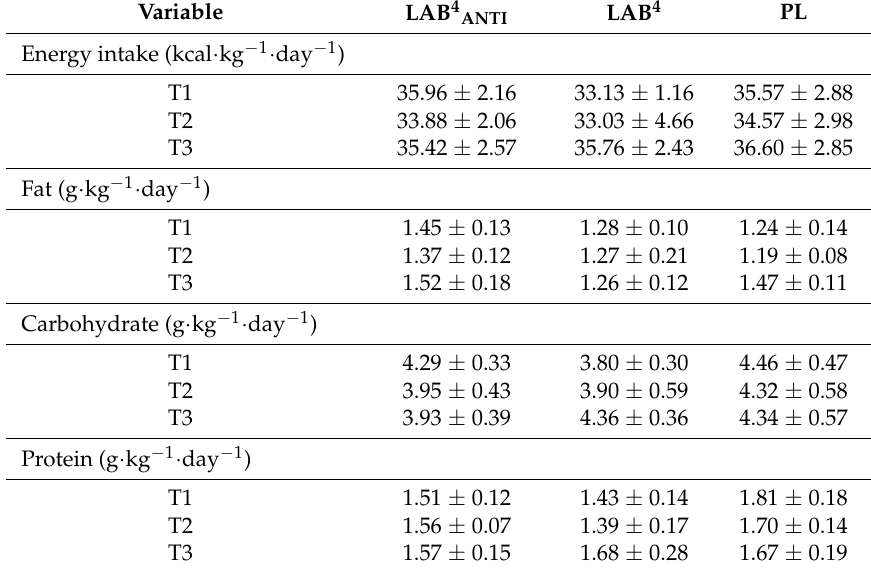
Table 2. Dietary analysis comparisons between